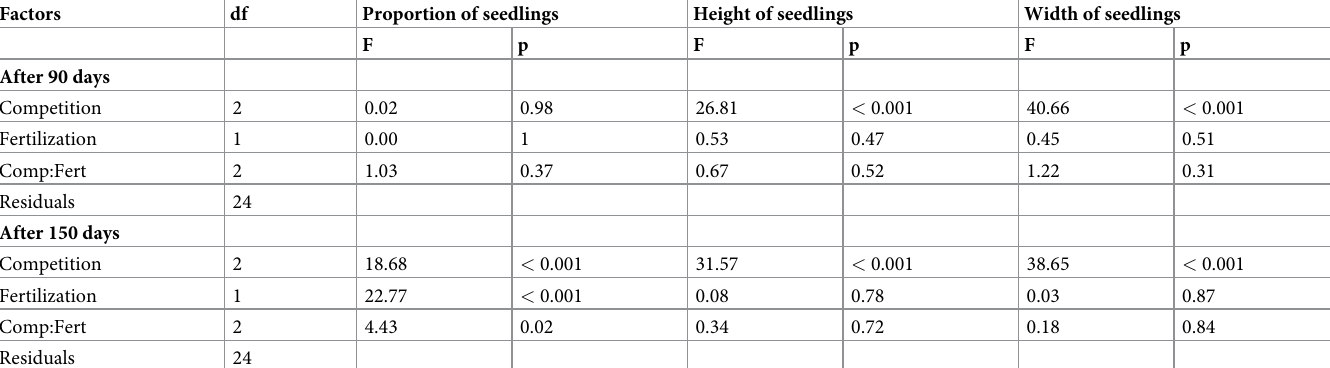
Table 1. Effects of treatments (competition, fertilization) and their interactions on A . montana seedlings. Shown are the results of analysis of variance on proportion of seedlings, height and width of rosettes concerning the two sampling points (90 and 150 days after seeding of A . montana ) with degrees of freedoms (df), test statistics (F), and